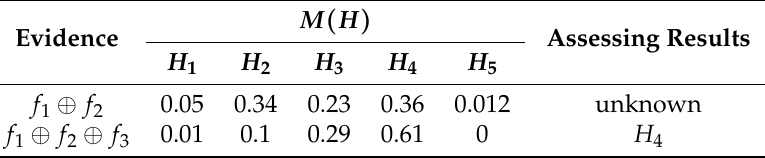
Table 7. Result of evidence